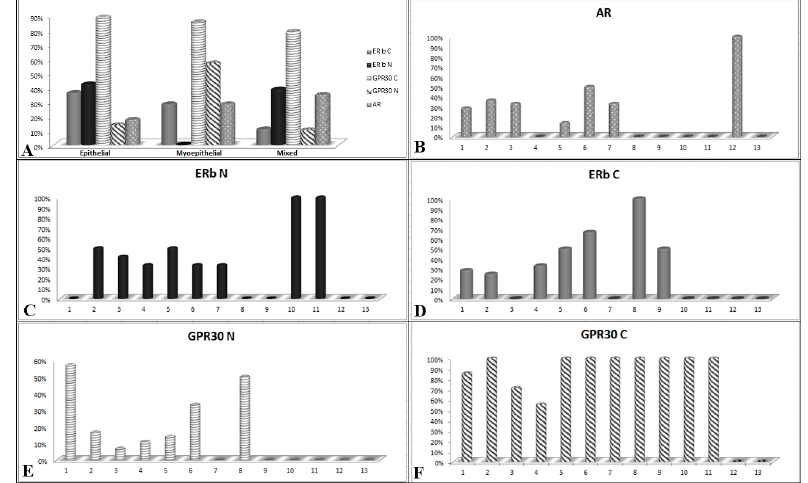
Figure 1. Schematic representation of distribution of Androgen Receptor (AR), Estrogen Receptor Beta (ER β ) and G protein-coupled receptor 30 (GPR30 IHC) expression in salivary gland tumors (SGTs): ( A ) AR, ER β and GPR30 expression in cell differentiation SGT types (epithelial, myoepithelial and mixed); ( B ) nuclear AR expression in different histotypes; ( C ) nuclear ER β expression in different SGT histotypes; ( D ) cytoplasmic ER β expression in different SGT histotypes; ( E ) nuclear GPR30 expression in different SGT histotypes; ( F ) cytoplasmic GPR30 expression in different SGT histotypes. X = SGTs histotypes; Y = number of positive samples in percentage